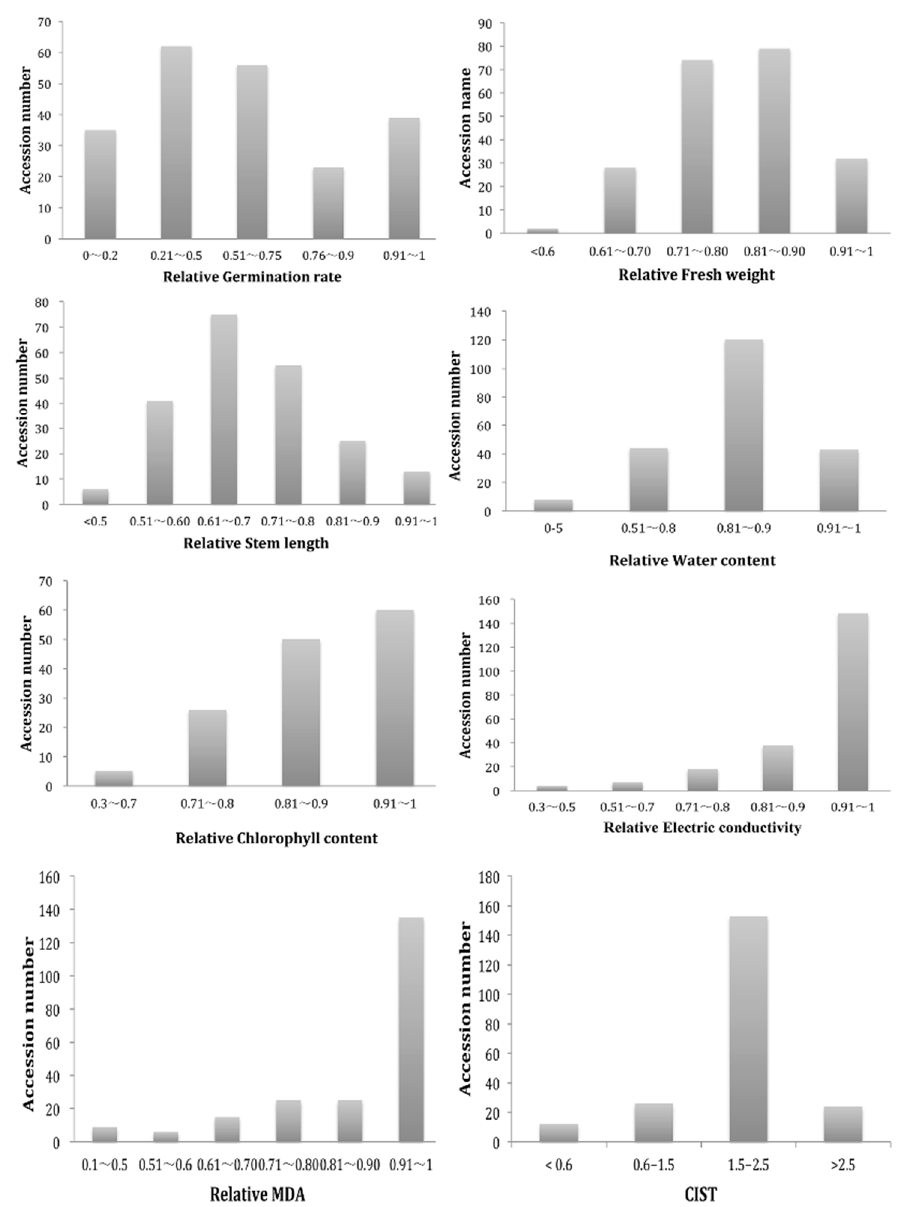
Figure 1. Relative value frequency distribution diagram of seven salt tolerance traits and one salt tolerance index of 215 G. arboreum accessions.